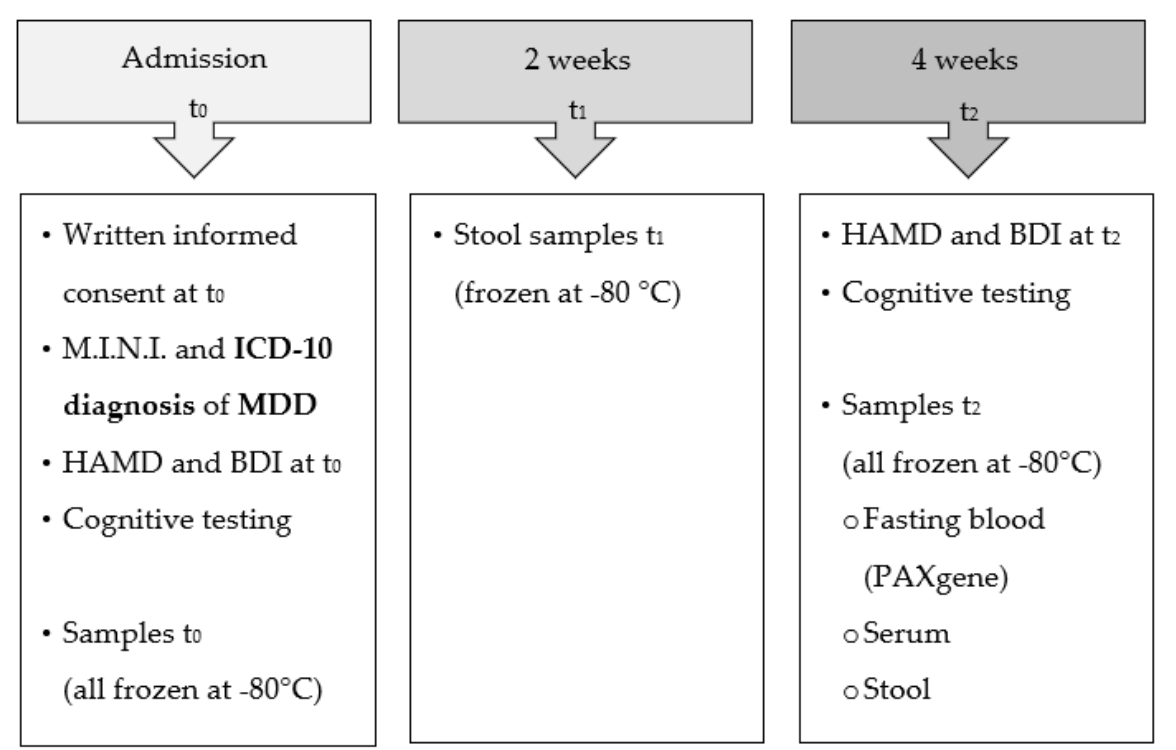
Figure 1. Overview of the PROVIT study design. HAMD = Hamilton Rating Scale for Depression, BDI-II = Beck Depression Inventory-II, M.I.N.I. = Mini International Neuropsychiatric Interview, ICD10 = International Statistical Clas- sification of Diseases and Related Health Problems, MDD = Major Depressive